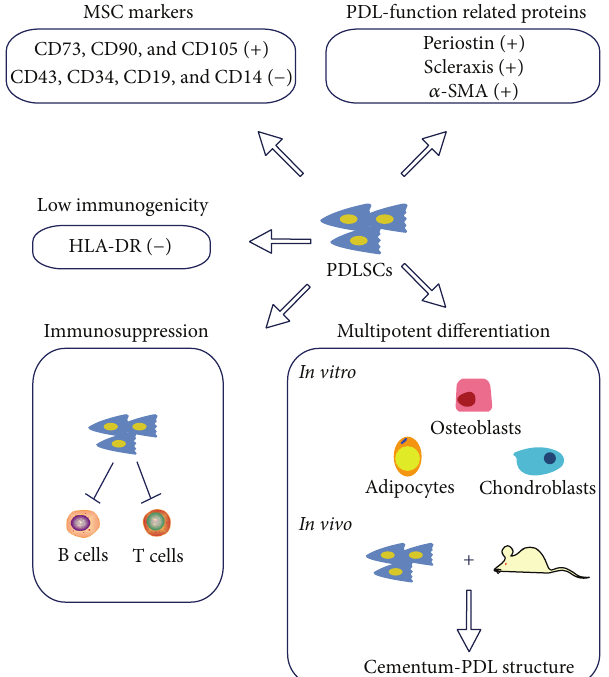
Figure 2: Criteria for identification of periodontal ligament stem cells. PDLSCs share similarities with MSCs in terms of antigenic phenotype and multipotent differentiation potential in vitro . In addition, PDLSCs also possess low immunogenicity and immunosuppressive ability, similartoMSCs.However, PDLSCsdifferfromMSCderived fromothertissuesororgans, suchasexpression ofPDL-functionrelated proteins (periostin, scleraxis, and 𝛼 -SMA) and forming a cementum-PDL structure in vivo